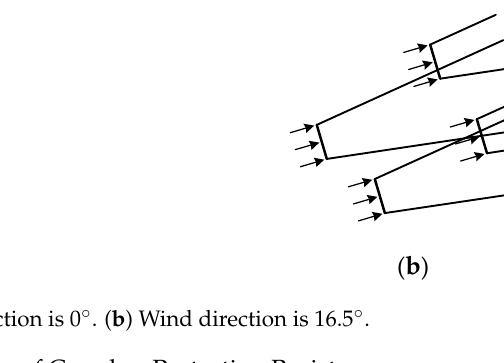
Figure 2. Scheme of overlapped wake model.